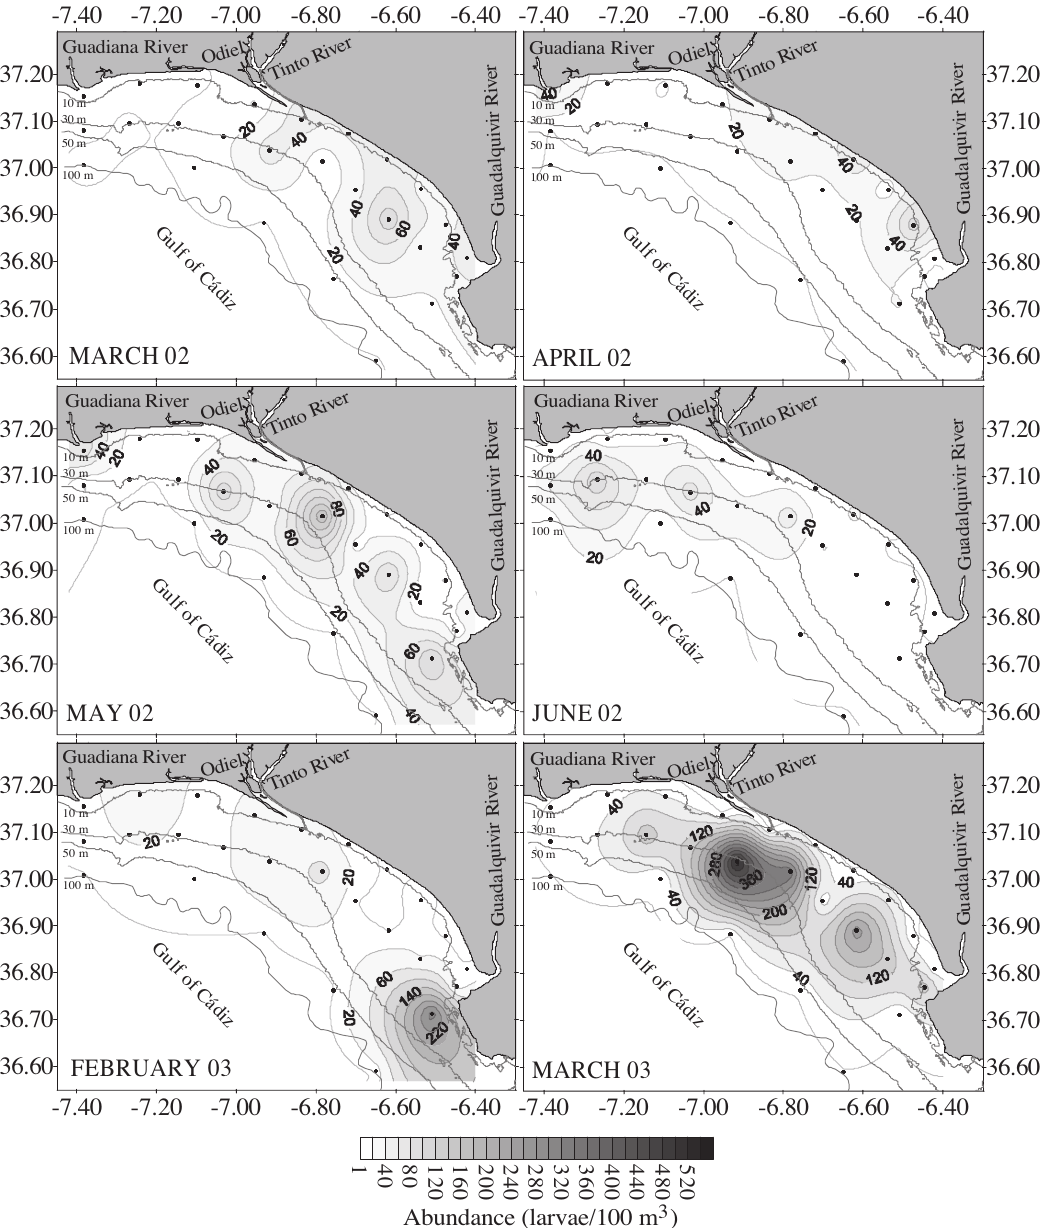
F IG . 3. – Horizontal distribution of the abundance of wedge sole larvae (number/100 m 3 ) during the main reproduction